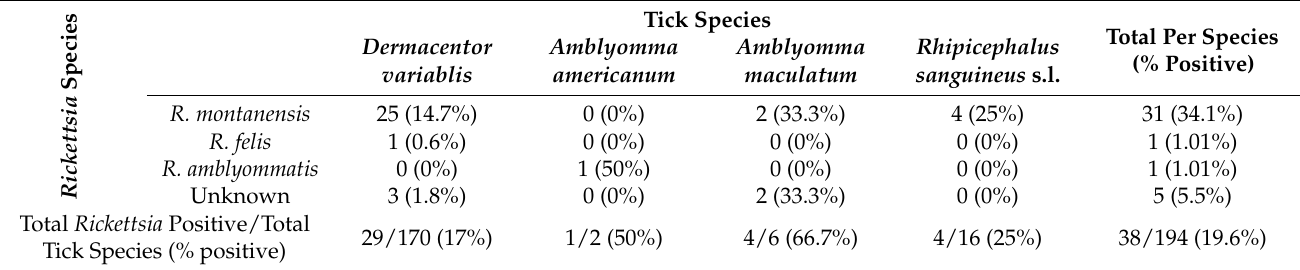
Table 1. Total numbers of tick species and associated Rickettsia